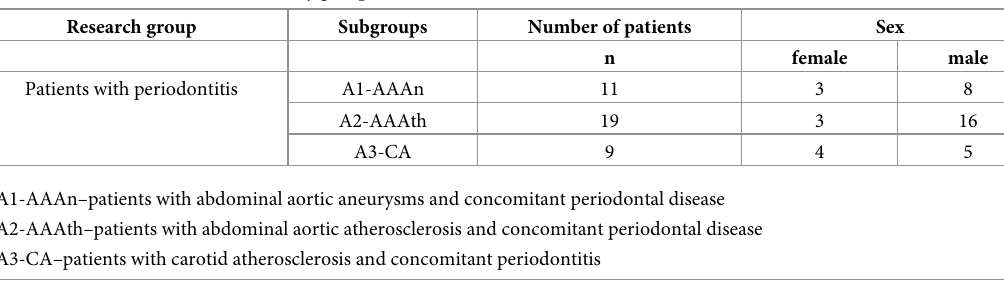
Table 1. The characteristics of the study